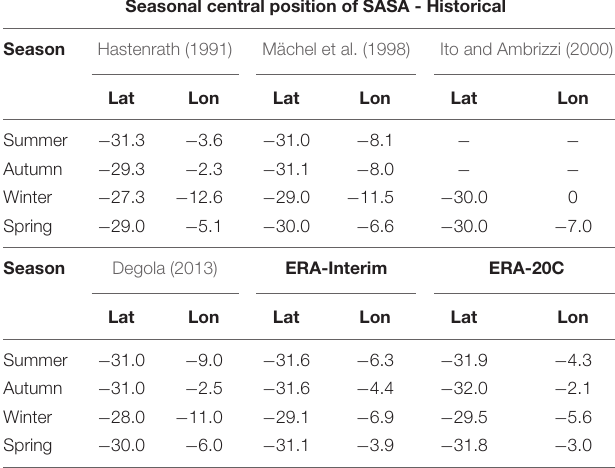
TABLE 1 | Seasonal climatology of the highest SASA pressure center (latitude and longitude) in the present climate (1979–2005) obtained from ERA-Interim, ERA20C and the literature (see text citations).